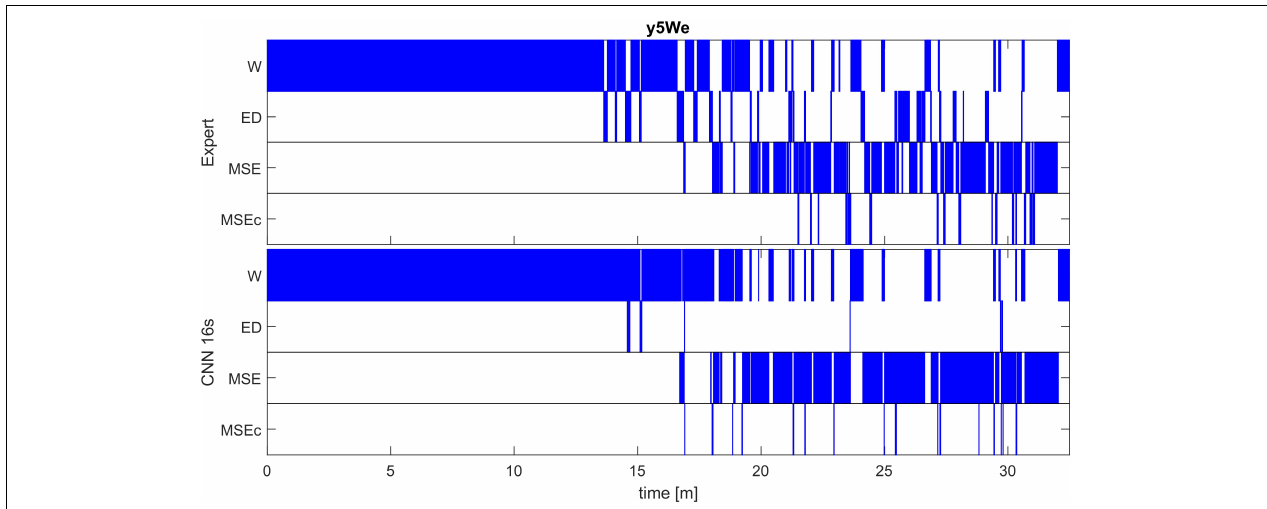
FIGURE 3 | Expert (top) and automatic soring with one algorithm (CNN with 16-s window; bottom) of an MWT (40 min) in one patient of the validation set (patient y5We). A good match between the algorithm and an expert scoring for wakefulness (W) and microsleep episodes (MSE) are evident, but a poor match for episodes of drowsiness (ED) and microsleep episode candidates (MSEc). Scoring was performed with the resolution of one sample; for the illustration, we coarsened the result to a resolution of 0.5 s (100 samples), i.e., the most frequent class within an interval was plotted. Results for other patients of the validation set are illustrated in Supplementary Figure S1 , those of the test set in Supplementary Figure S2 .